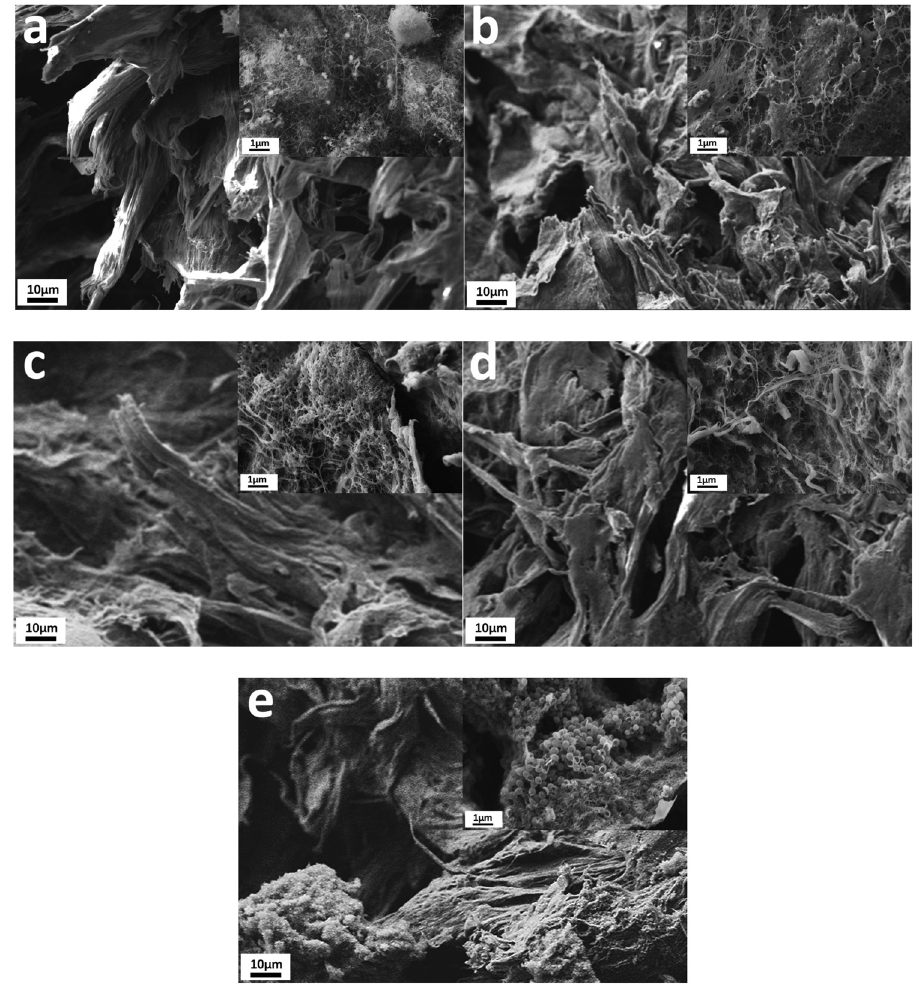
Figure 1: SEM images of: ( a ) MWCNT/foam - 20, ( b ) MWCNT/foam - 40a, ( c ) MWCNT/foam - 40b, ( d ) MWCNT/foam - 40c, and ( e ) MCHMs/MWCNT/foam - 40; the scale bar is 10 µm and 1